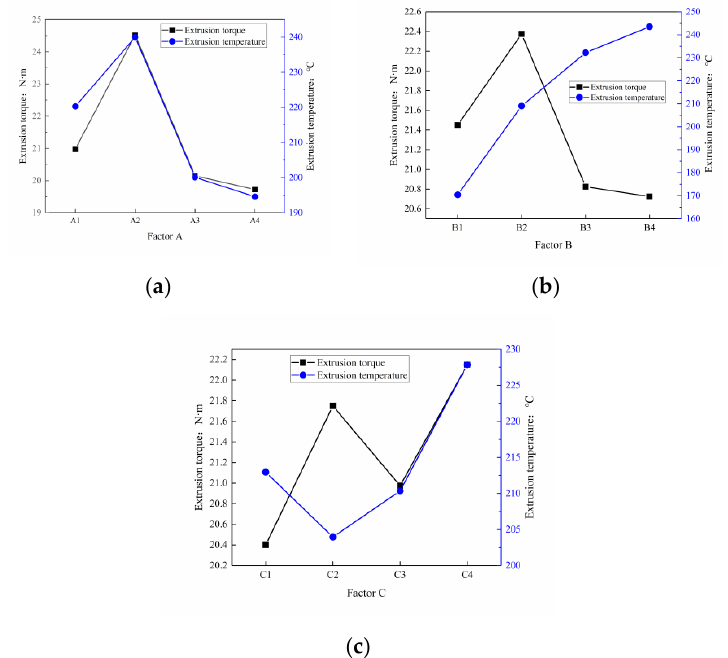
Figure 9. The influence of various factors on the test index: A factor ( a ), B factor ( b ), and C factor( c ).